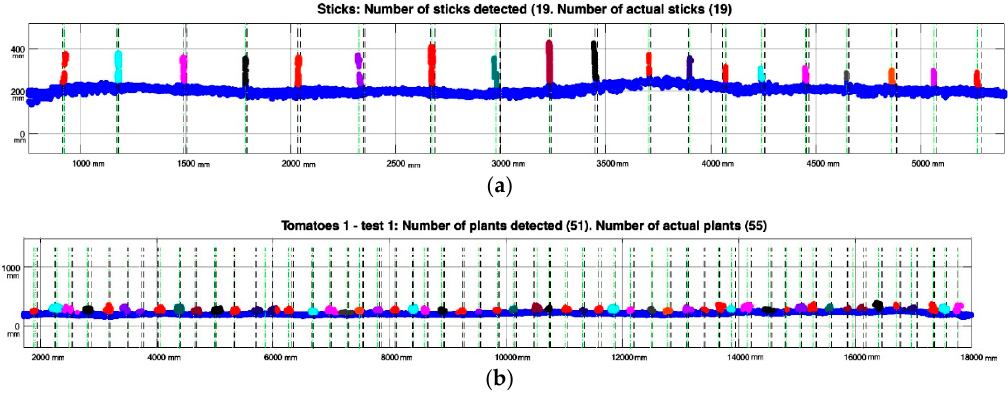
Figure 10. Detection results on three tested lines. Green dotted lines represent the cluster centre and black dotted lines the real plant interval obtained by the Kinect image (location ± Std.). ( a ) 19 stick detections using LiDAR; ( b ) 51 plants detected during Test 1 in row 1.